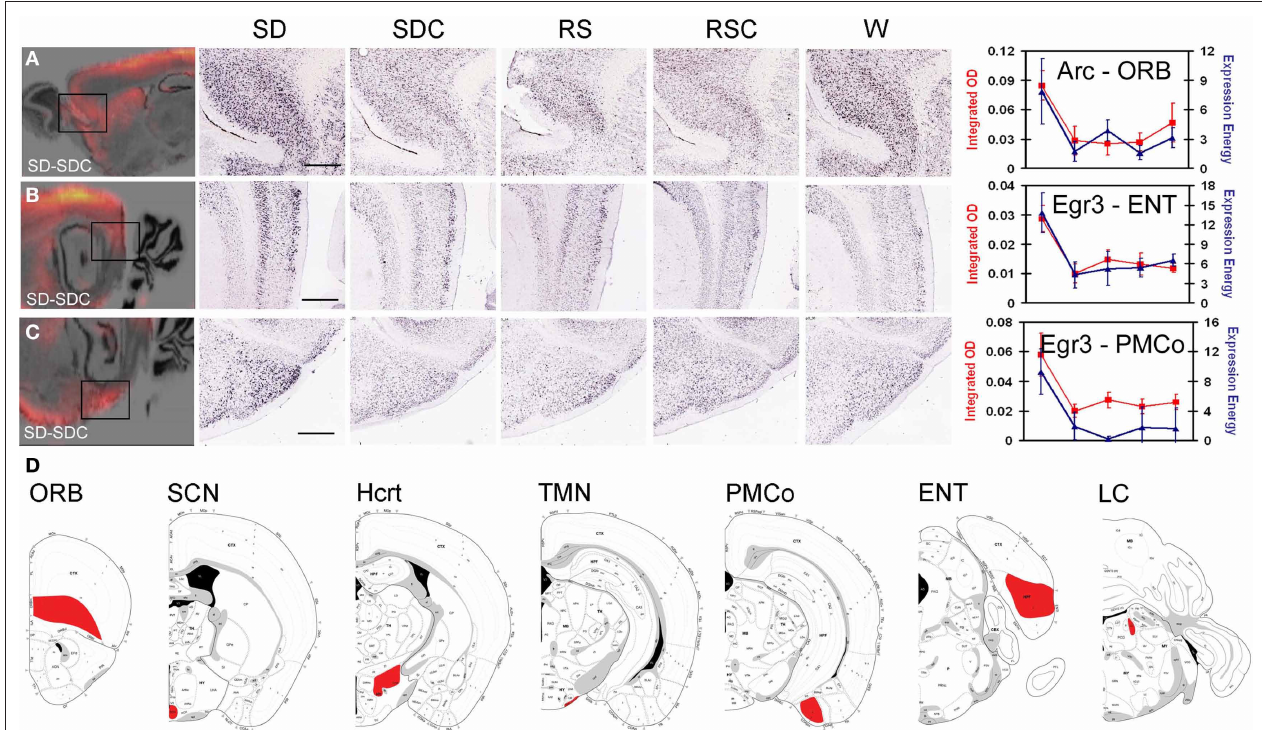
to the boxed areas in the difference grids. Right panels show quantification of SD induction using automated informatics quantification (blue) and